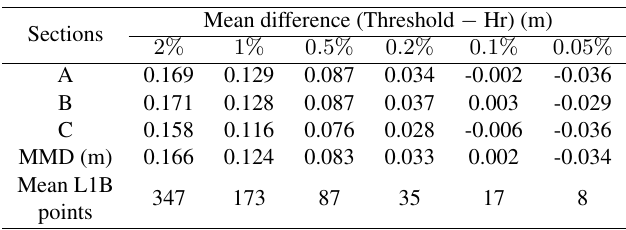
Table 2. The mean difference of sea surface heights derived from threshold method and manual selection over selected DMS images with leads